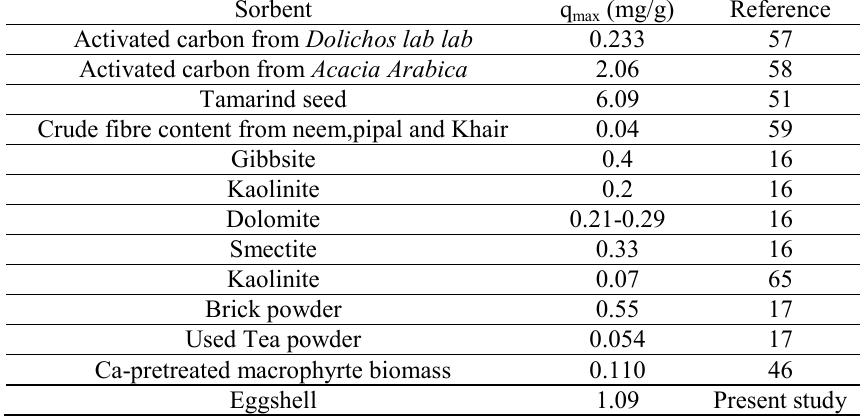
Table 3. Comparison of fluoride adsorption capacity of eggshell powder with other reported